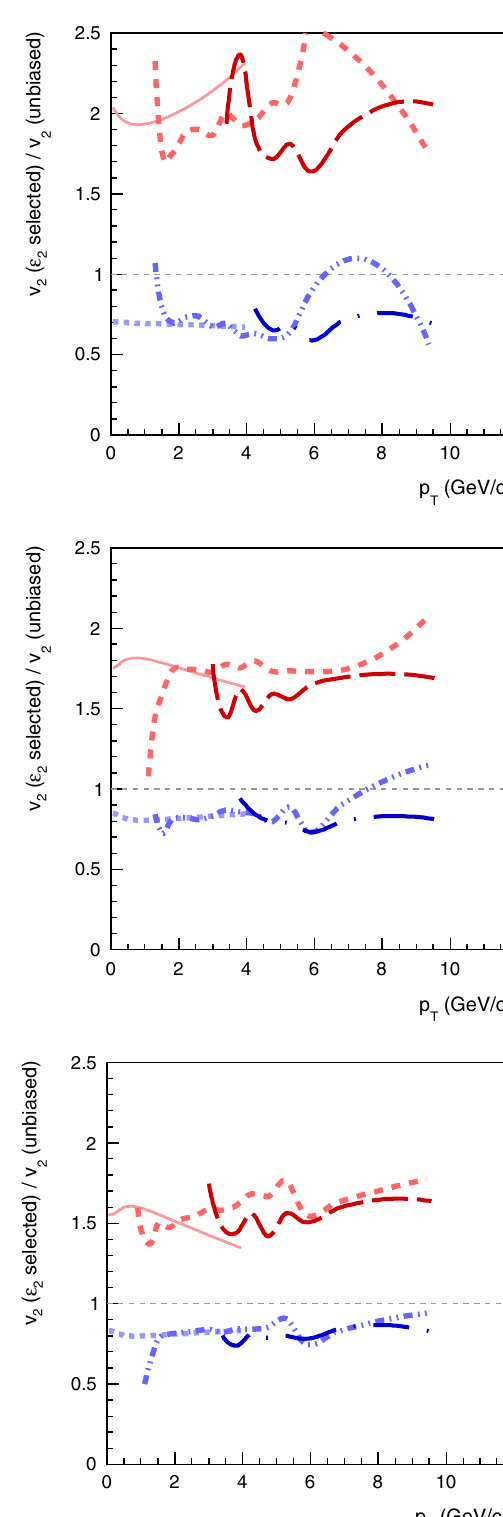
Fig. 17 Systematic comparison of the effect of the eccentricity selec- tion on the elliptic flow of light and heavy flavour hadrons in the 0–10% (top), 10–30% (middle) and 30–50% (bottom) most central Pb–Pb col-